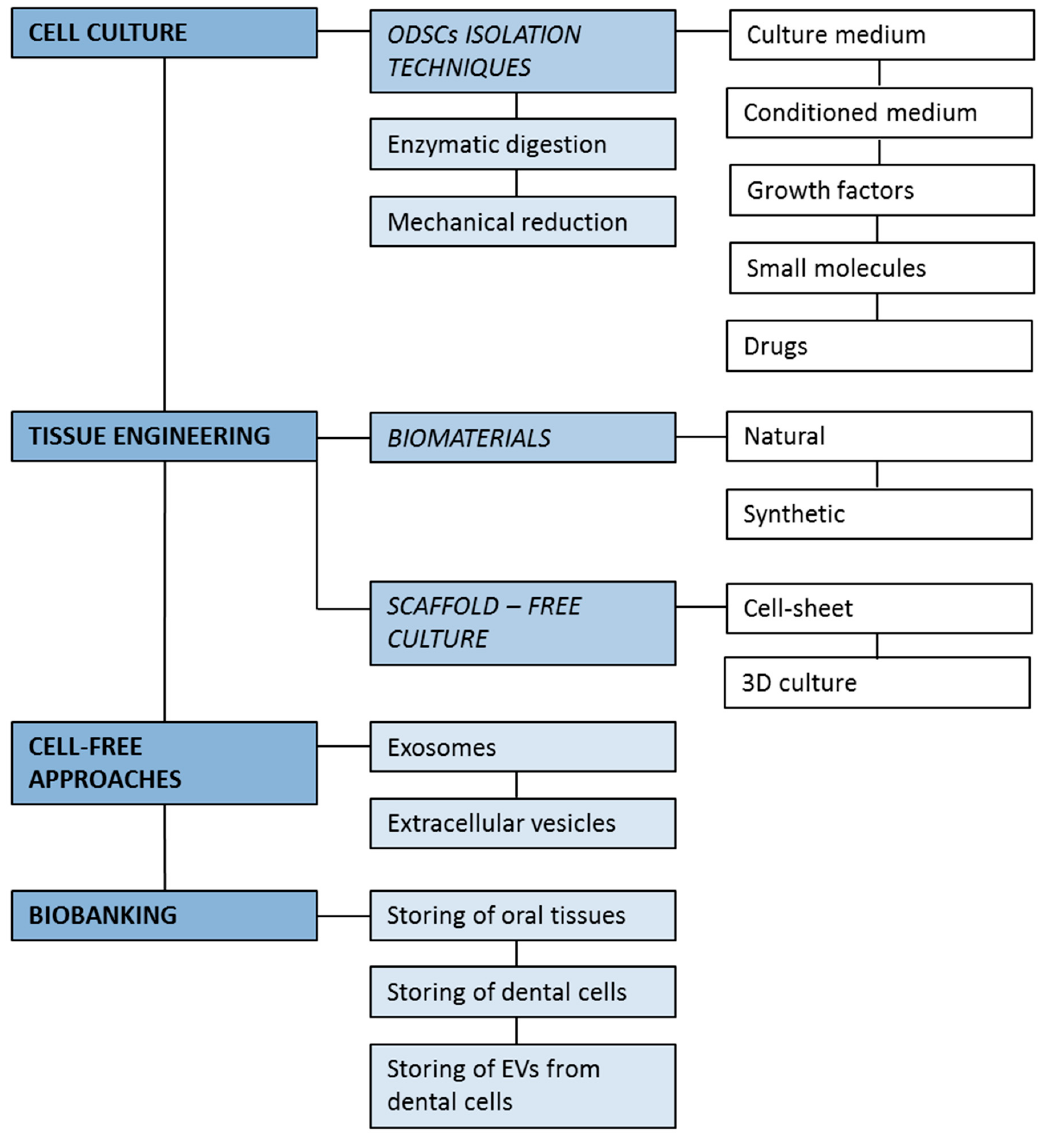
Figure 2. Innovative approaches in regenerative dentistry.